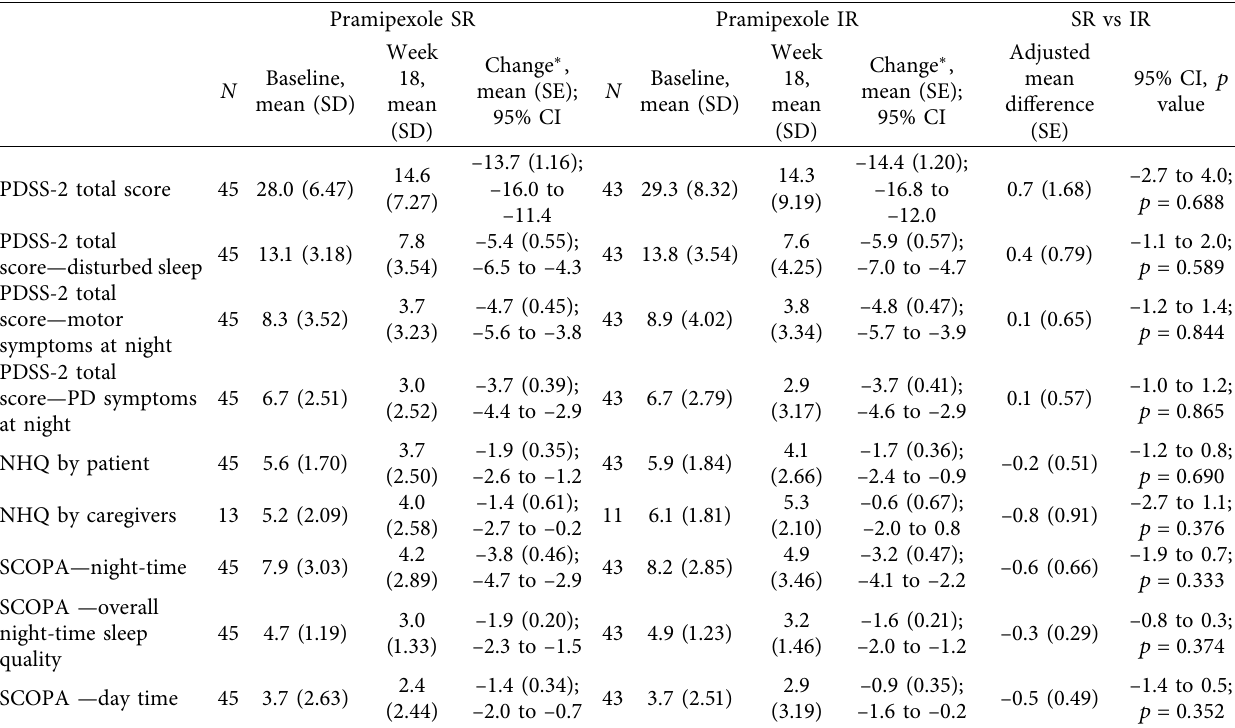
Table 3: Adjusted mean changes in primary and secondary efficacy endpoints at week 18 from baseline